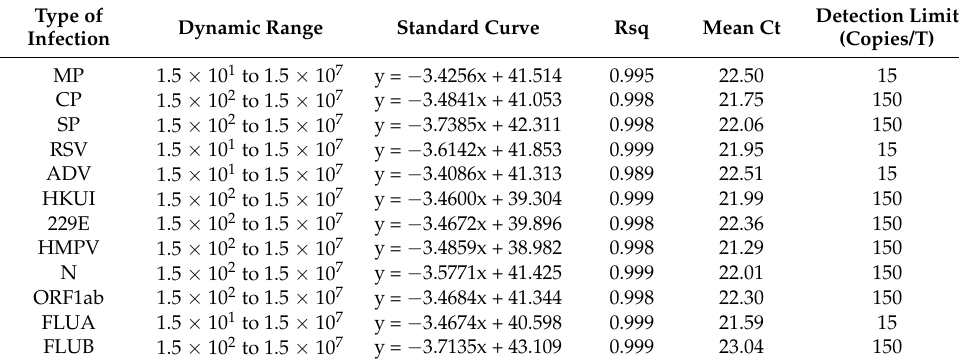
Table 3. Summary of sensitivity of off-chip RT-qPCR.